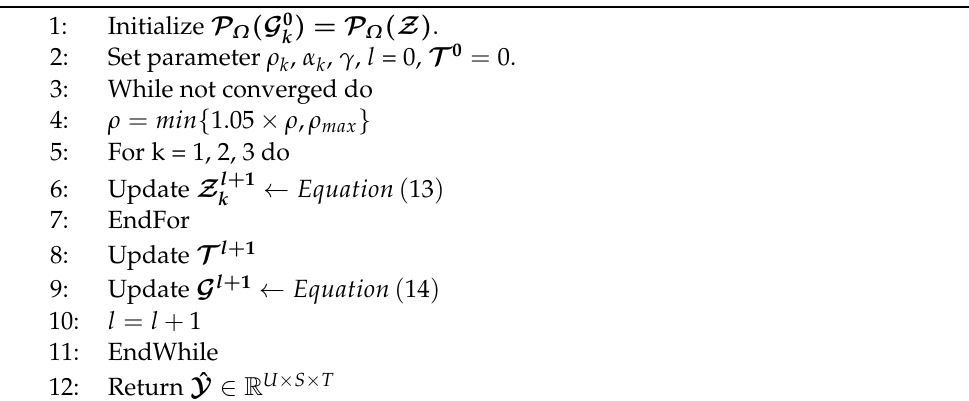
Algorithm 2: TLTC Optimization Imputation Algorithm.